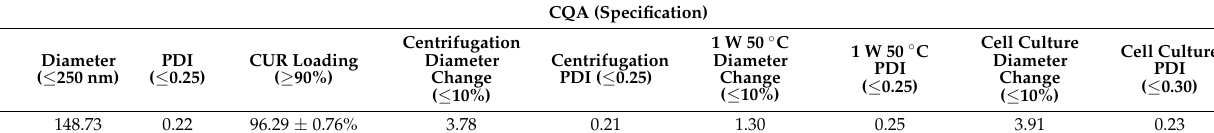
Table 5. Summary of CQA specification testing for CUR-loaded nanoemulsion and scale-up.